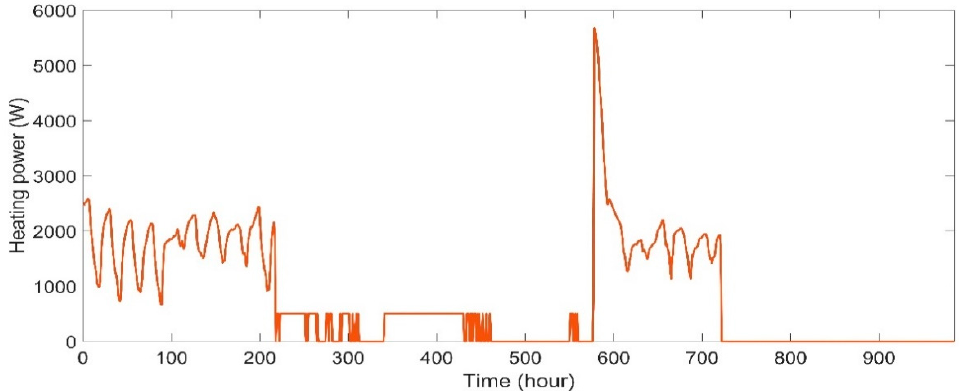
Figure 7. Measured heat power for a building calculated from the presented data in [28].